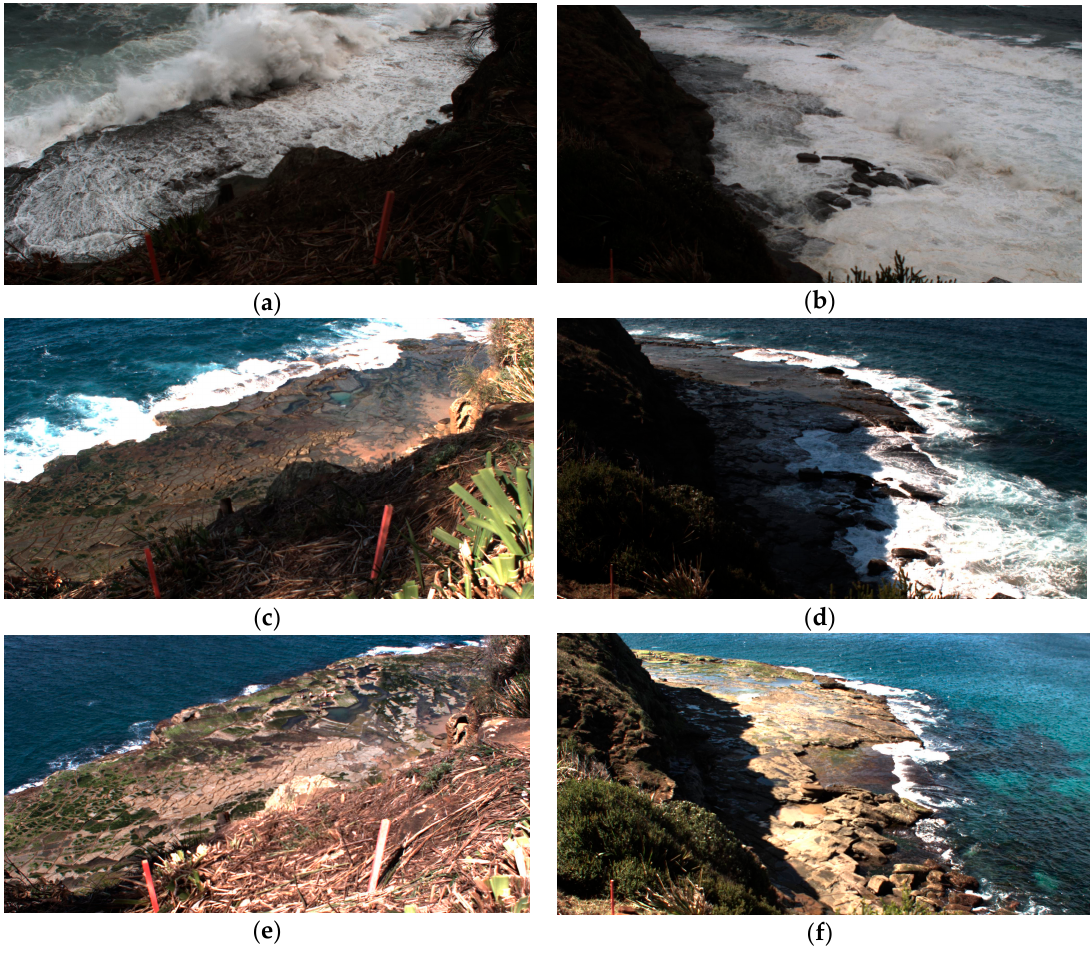
Figure 6. Examples of frames collected by the camera system under different conditions: high energy conditions ( H s = 3.12 m, T m 01 = 9.2 s, D p = 160°) on 27 April 2017 at 17:00 at ( a ) the north camera and ( b ) the south camera; moderate energy conditions ( H s = 1.41 m, T m 01 = 6.62 s, D p = 150°) on 11 May 2017 at 10:00 at ( c ) the north camera and ( d ) the south camera; and low energy conditions ( H s = 0.47 m, T m 01 = 4.8 s, D p = 100°) on 10 April 2017 at 11:00 at ( e ) the north camera and ( f ) the south camera.